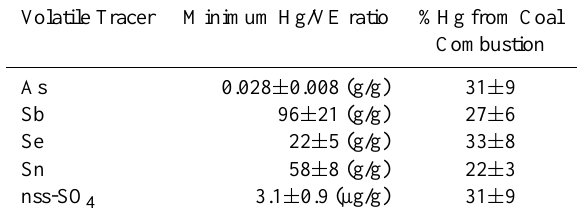
Table 3. Minimum Hg/volatile element mass ratios used with Eq. (1) to estimate the fraction of rainfall Hg due to coal combustion in the southeastern US. Volatile Tracer Minimum Hg/VE ratio %Hg from Coal Combustion As 0.028 ± 0.008 (g/g) 31 ± 9 Sb 96 ± 21 (g/g) 27 ± 6 Se 22 ± 5 (g/g) 33 ± 8 Sn 58 ± 8 (g/g) 22 ± 3 nss-SO 4 3.1 ± 0.9 (µg/g) 31 ±